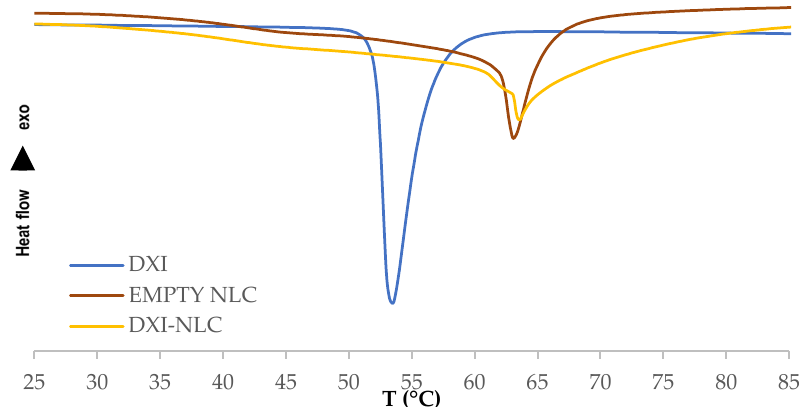
Figure 3. Differential scanning calorimetry (DSC) of DXI-NLC, DXI and empty NLC. DXI is encapsulated in the NLC matrix. An X-ray diffractogram (XRD) was performed to characterize the DXI-NLC crystal- line in its amorphous state (Figure 4). The XRD profiles of DXI present sharp peaks indi- cating crystalline structure, while the empty NLC shows two high diffraction peaks (2 θ : 21.4 and 23.8) corresponding to orthorhombic subcell diffraction of waxes [40]. Interest- ingly, in DXI-NLC, the intensity of these two peaks slightly dropped.